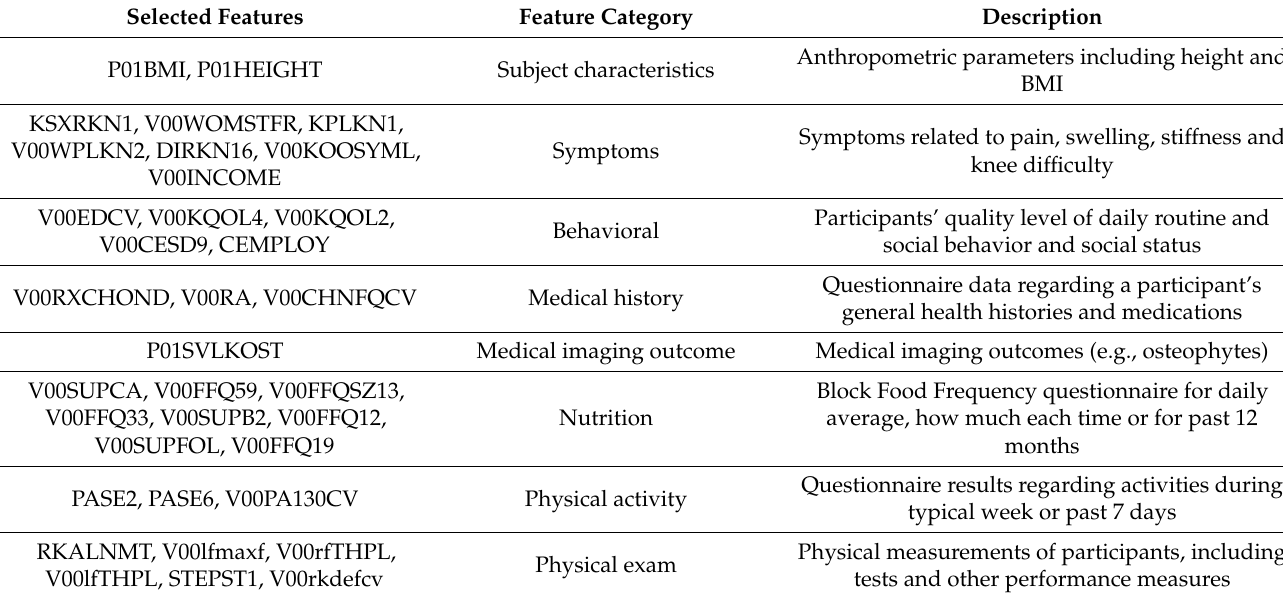
Table 4. Characteristics of the 35 most informative risk factors as selected by the proposed GenWrapper. Selected